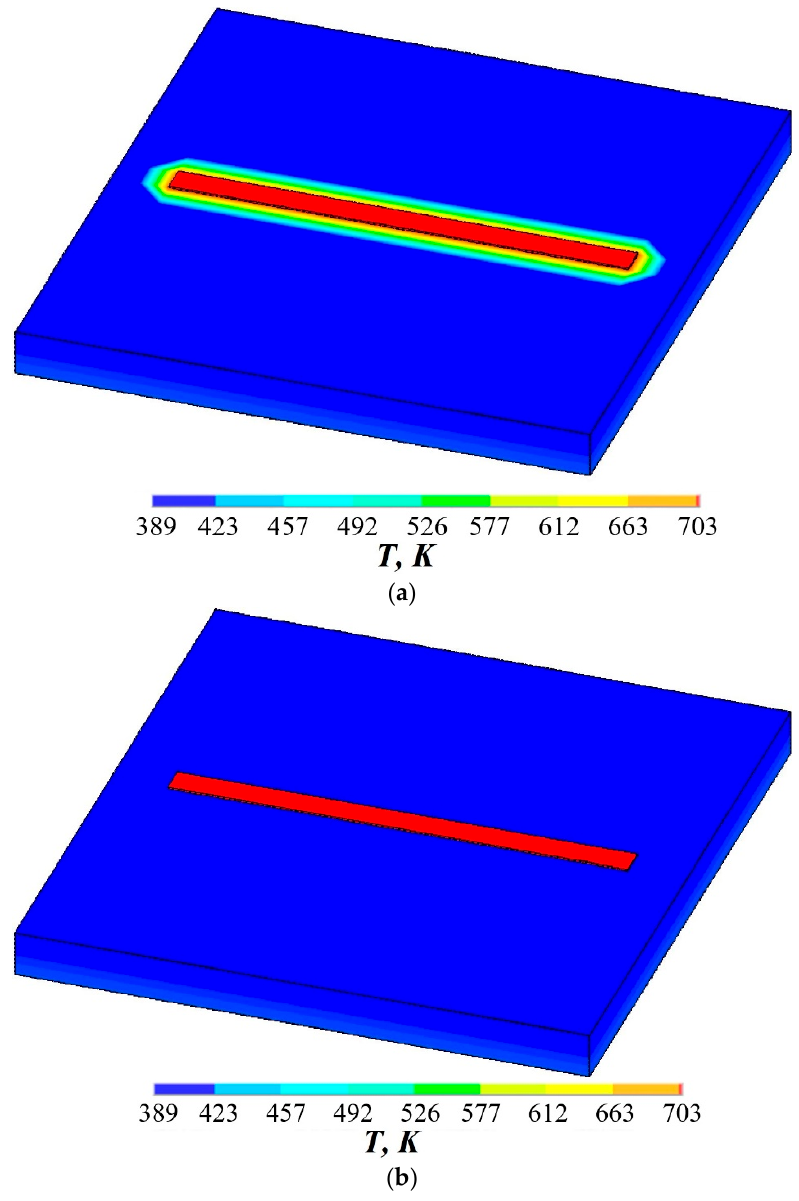
Figure 17. System at t = 1 · 10 − 5 s: ( a ) application of command CPINTF; ( b ) application of contact elements TARGE170 and CONTA173.